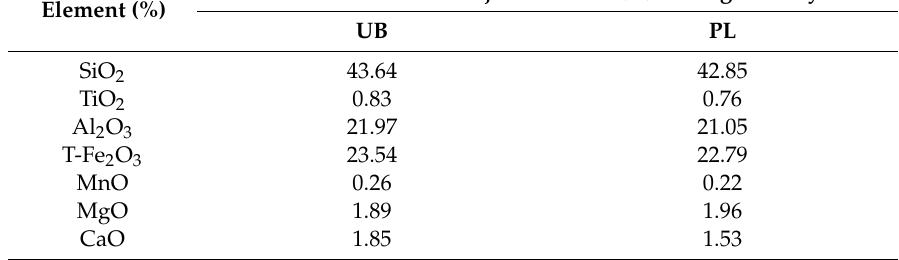
Table 1. The elements concentrations (%) of magnetic fractions of UB and PL fly ashes as determined by XRF